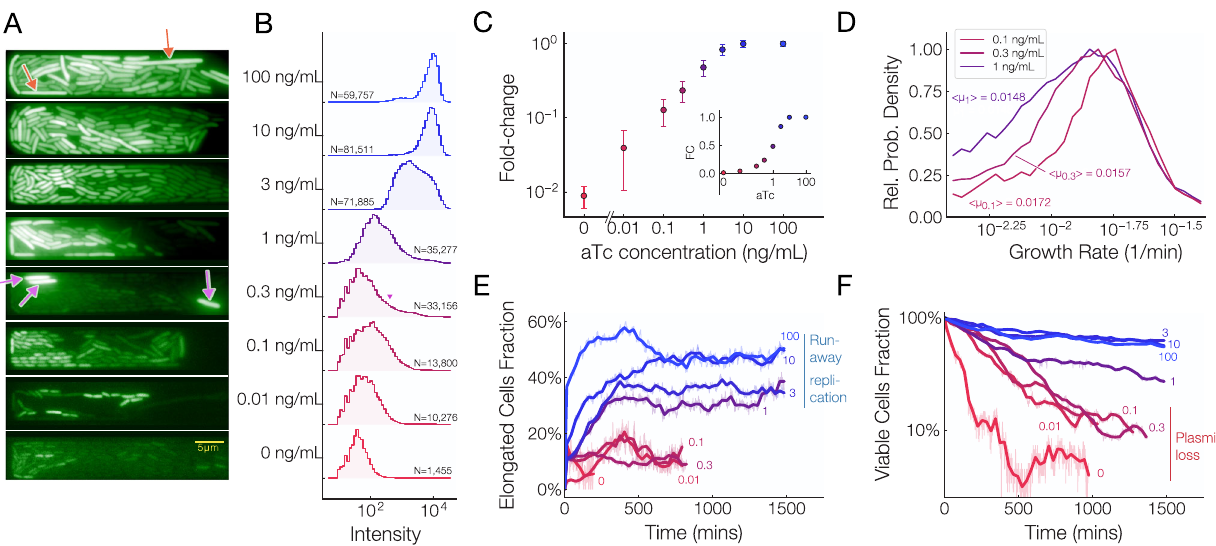
Fig. 3 Microscopic Analysis of sfGFP Expressed by the pUC-pTet. A Representative snapshots of micro fl uidic chambers at various aTc concentrations. Slow-growing cells at high copy number are indicated by orange arrows and cells at 0.3 ng/mL of aTc in an “ activated ” state are indicated by purple arrows. Experiments in 100 ng/mL and 0.1 ng/mL conditions were repeated twice with similar results, all other experiments were repeated once. B Distribution of cellular fl uorescence intensities at increasing aTc concentrations. C Normalized mean fl uorescence as a function aTc concentration, log scale. Inset: Normalized mean fl uorescence vs aTc concentration on a linear scale. N = number of cells listed in corresponding condition in Panel B . Data points are averages over all cells, error bars = std. dev. of distributions in panel B . D Growth rate distributions of cells grown at 0.1, 0.3, and 1 ng/mL aTc. E Fraction of slow-growing, elongated cells over time at several aTc concentrations. This measurement is indicative of the extent to which cells are burdened by the high plasmid copy numbers. F Proportion of viable cells as a function of time at various aTc concentrations. The sharp decrease in the number of viable cells at low aTc concentrations provides insight into the extent to which plasmid loss occurs at low copy